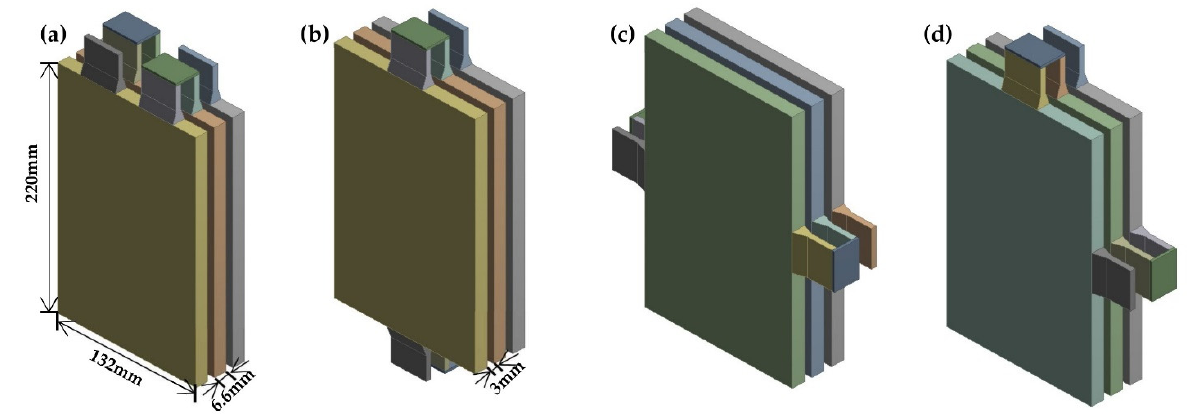
Figure 1. Four different terminal layouts named ( a ), ( b ), ( c ) and ( d ) in order.